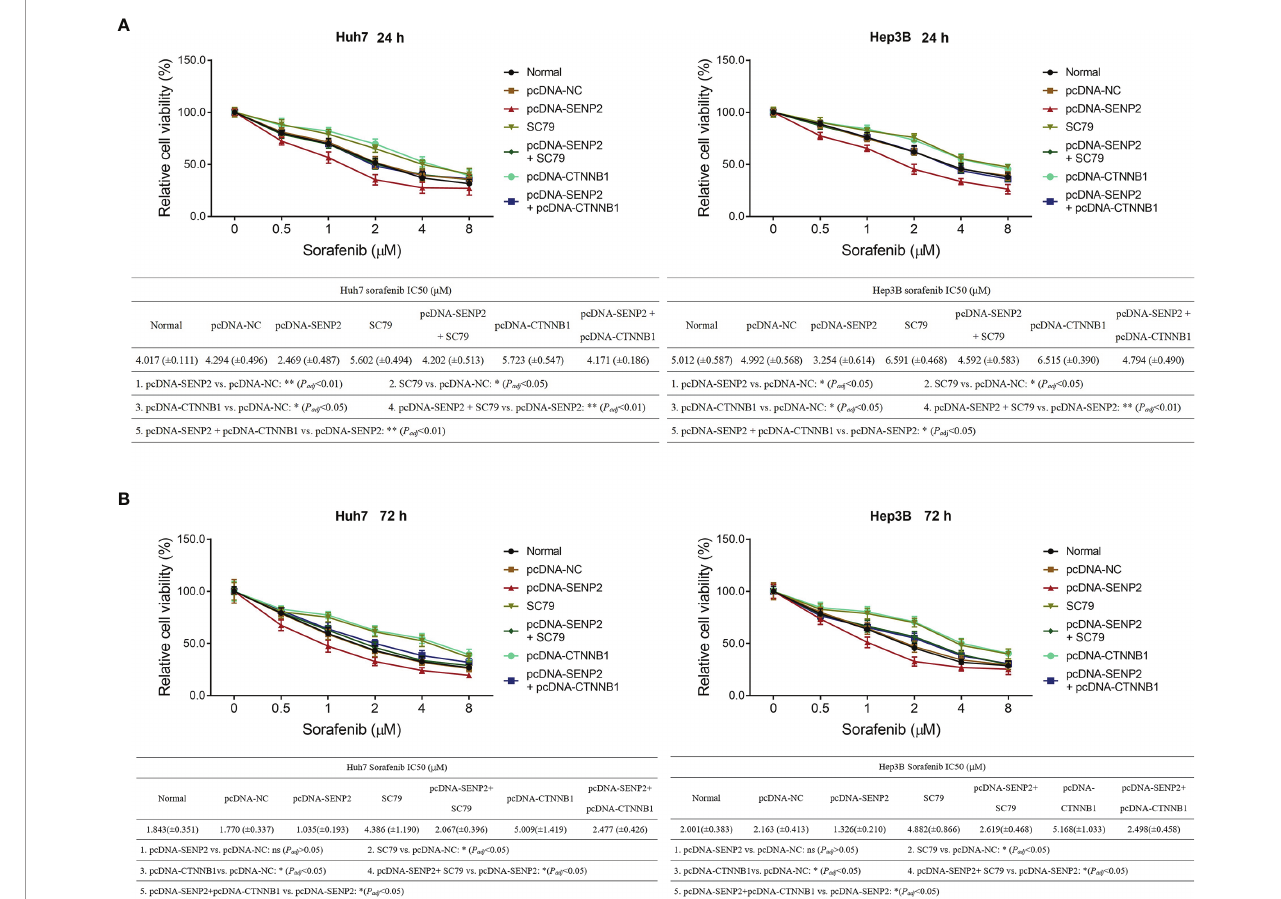
FIGURE 7 | Sorafenib sensitivity in compensation experiment. Relative cell viability under different doses of sorafenib treatment for 24 h and comparison of IC 50 value of sorafenib treatment for 24 h among groups in Huh7 and Hep3B cells in the compensation experiment (A) . Relative cell viability under different doses of sorafenib treatment for 72 h and comparison of IC 50 value of sorafenib treatment for 72 h among groups in Huh7 and Hep3B cells in the compensation experiment (B) . SENP2, Small ubiquitin- like modi fi er speci fi c peptidase 2; NC, negative control; CTNNB1, b -catenin; IC 50 , half maximal inhibitory